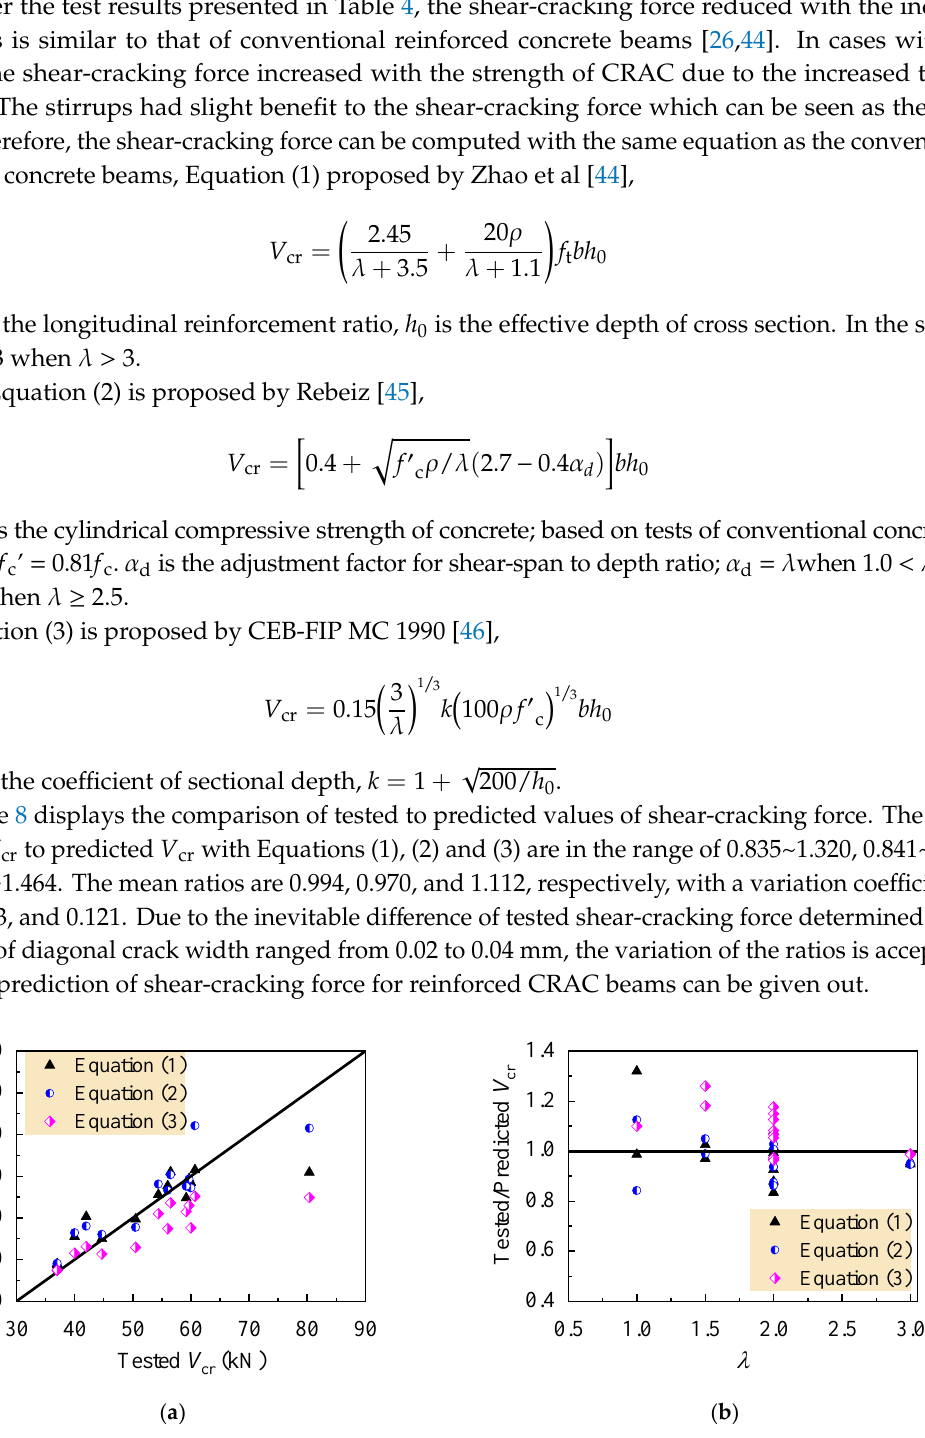
( b ) Figure 9. Cracks at points of stirrups intersecting shear-cracks of test beams: ( a ) λ = 1~3; ( b ) C30~C60. 4.5. Shear Capacity Different theoretical models have been proposed for reinforced concrete beams without web reinforcements based on the analysis of the shear strength of the uncracked concrete in a compression zone, the interlocking action of aggregates along the cracked concrete surfaces on the sides of the crack, the dowel action of the longitudinal reinforcement, and the simultaneous occurrence of both arch action and beam action [26,41–43,47]. The shear contribution of stirrups depends on the action which bridges the intersected critical diagonal cracks [26,31,48]. Therefore, the shear capacity of the reinforced concrete beam with stirrups can be simply superposed by the shear strengths provided separately by the concrete and stirrups. Based on this principle, the equation proposed by statistical analysis of a large number of experimental results of reinforced concrete beams is used to predict the shear capacity of reinforced CRAC beams, as follows [48]: h u